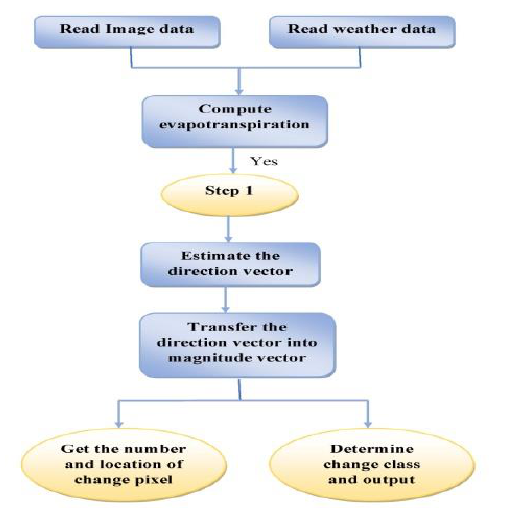
Figure 2. Flowchart of